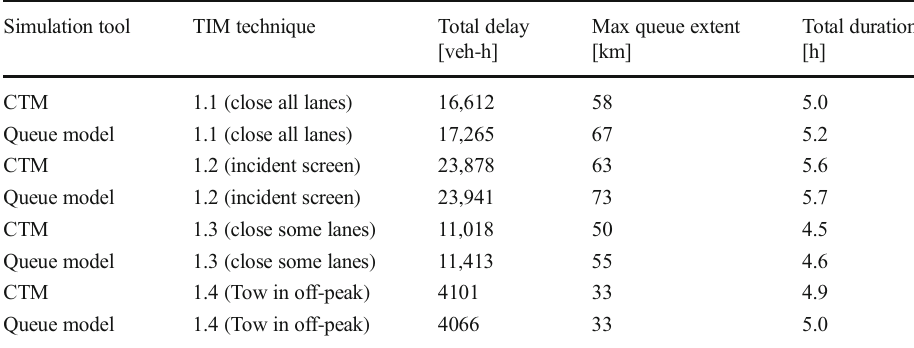
Table 9 Comparing incident estimations simulated by CTM-v and queue model for Scenario 1 (Collision). Comparing only congested locations upstream of the incident and using traffic de- mand measured at the scene